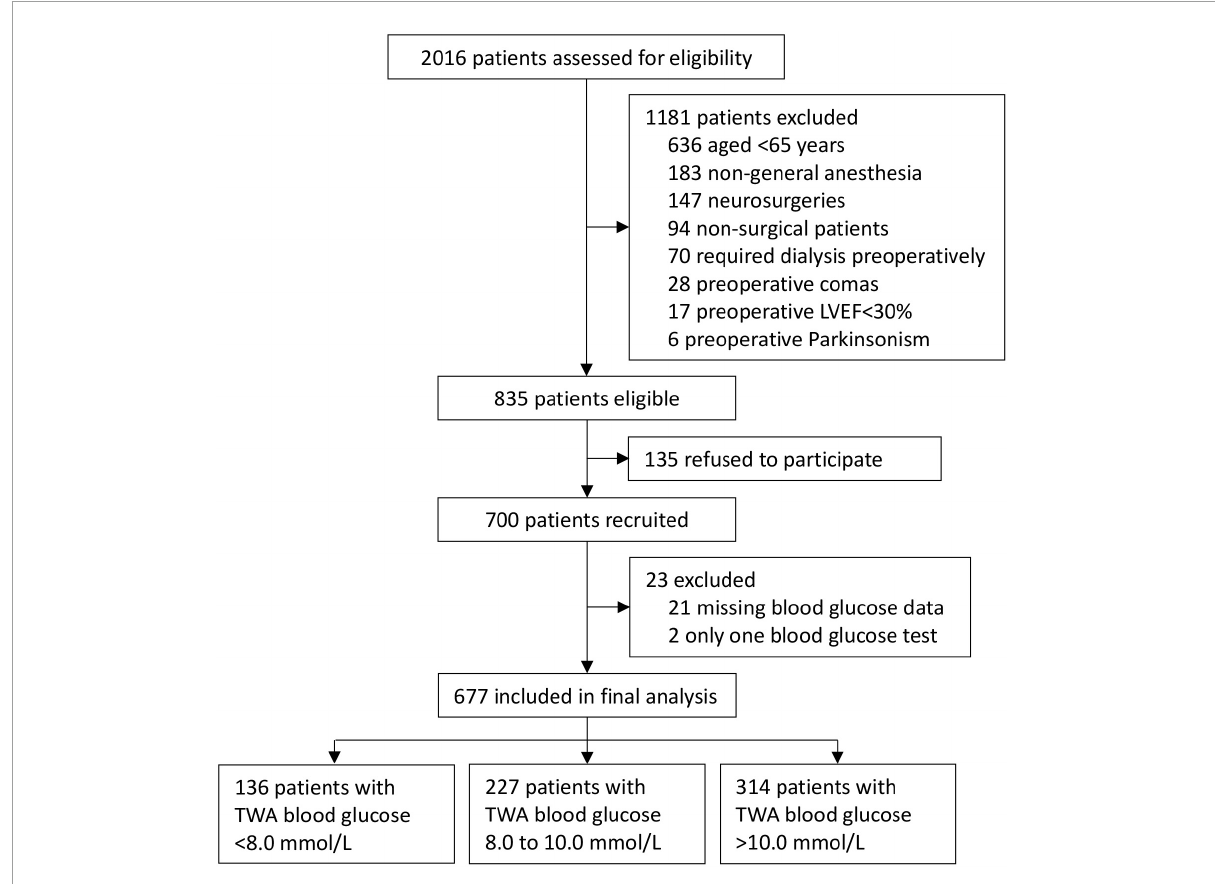
FIGURE1 Flow chart of the